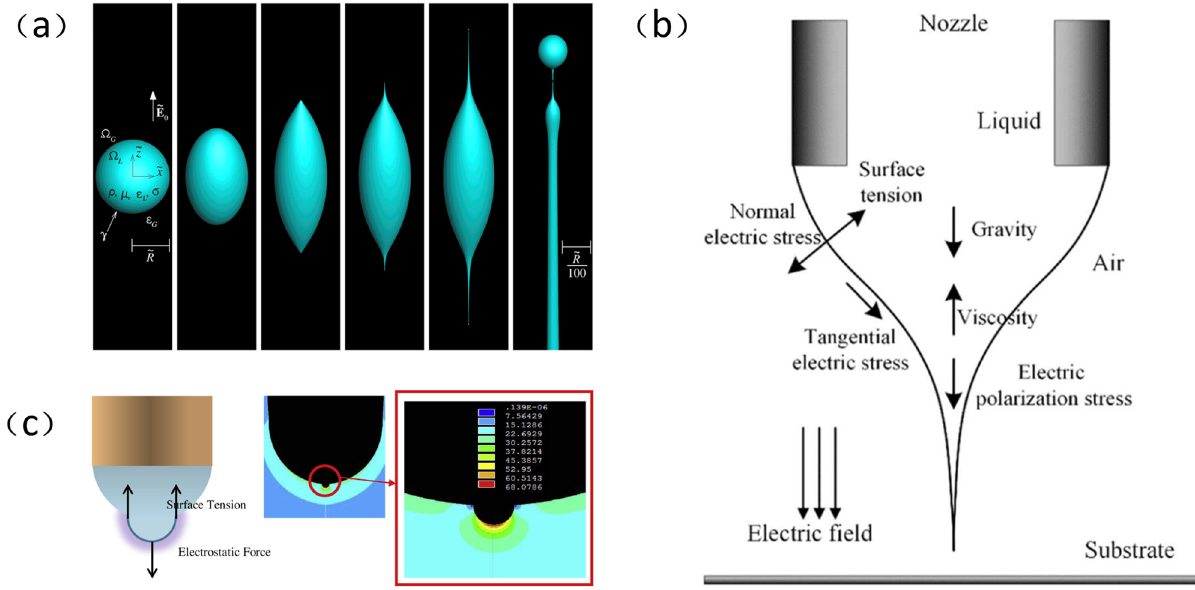
Figure 2: ( a ) The detailed process diagram of the droplet deposition, from the spherical shape to the Taylor cone at both ends and then to the droplet pinching o ff . Reproduced from ref. [ 41 ] with permission from the National Academy of Sciences. ( b ) Coupling distribution map of various forces of cone jet ejection based on the dielectric model. Reproduced from ref. [ 42 ] with a permission from MDPI ( Basel, Switzerland ) . ( c ) Finite element analysis of the hemispherical meniscus at the tip of the nozzle and the surrounding electric fi eld distribution map. Reproduced from ref. [ 43 ] with a permission from Elsevier